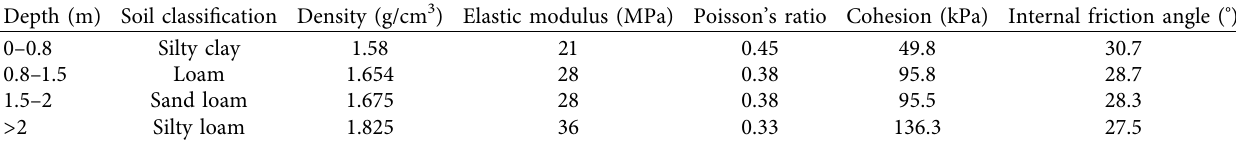
Table 1: Soil layer conditions and physical and mechanics parameters of soil body [12].